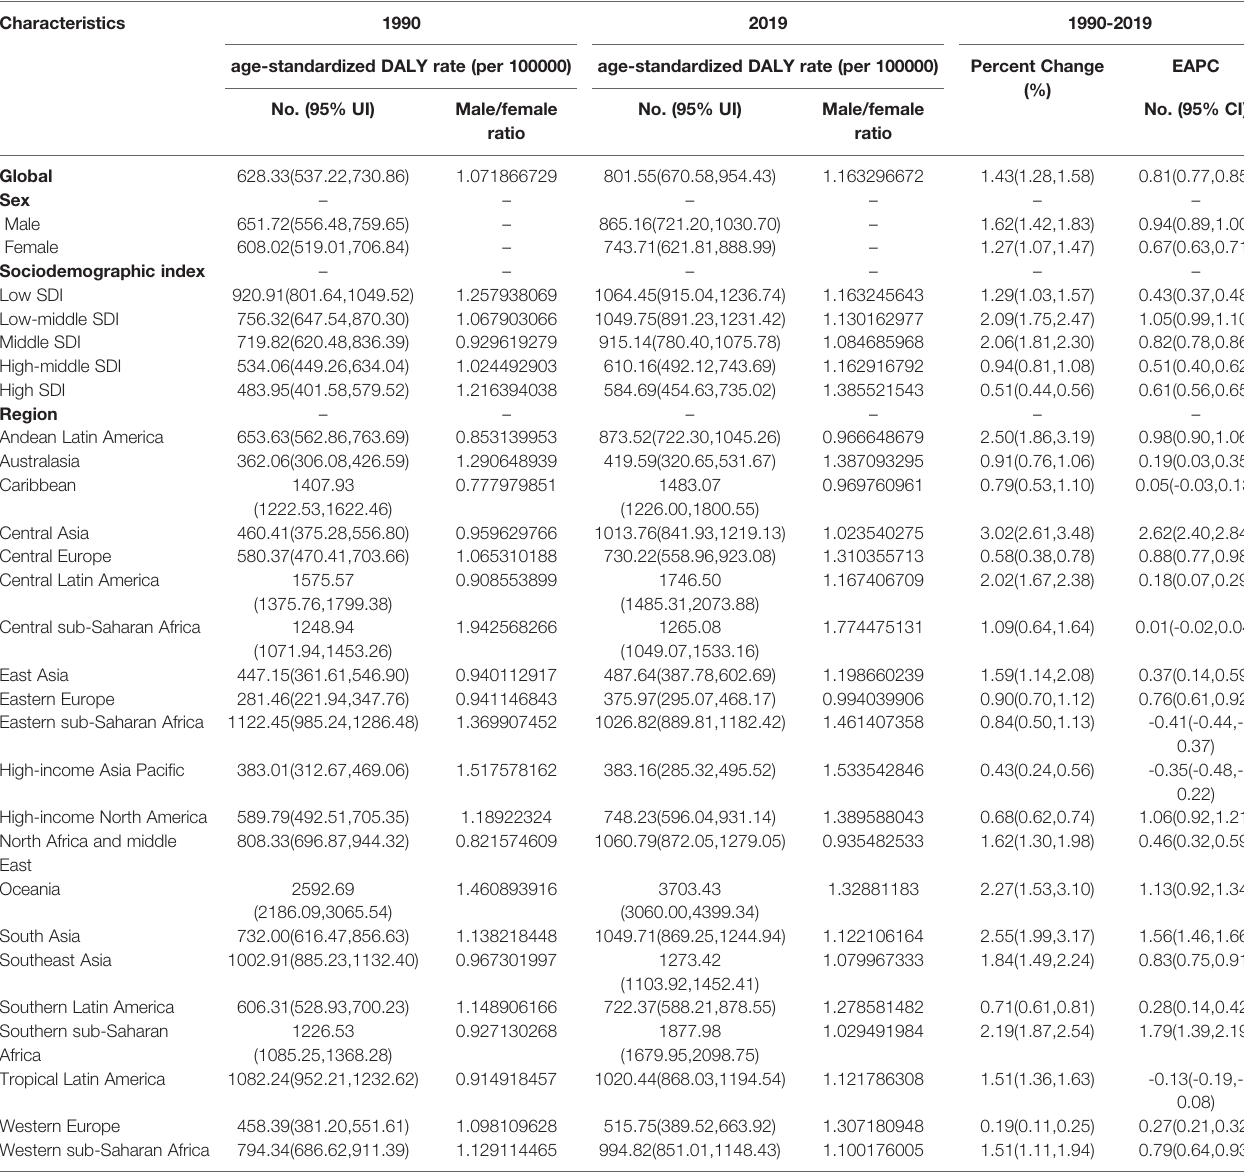
TABLE 3 | The age-standardized DALY rate of T2DM in 1990 and 2019 and its temporal trends.